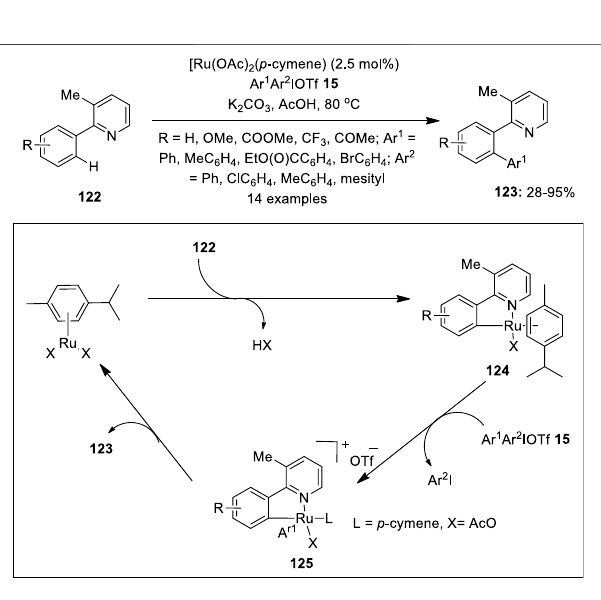
Frontiers in Chemistry |